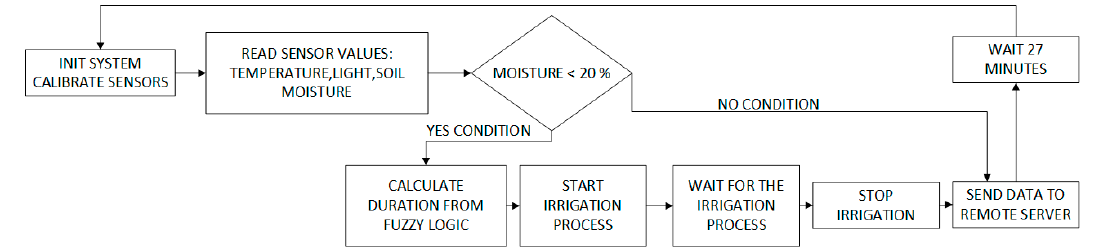
Figure 6. Process workflow: the main loop introduces a time delay in the whole process. Once the sensors are calibrated and measures obtained, the moisture level is checked. If the humidity crosses a given threshold, data is sent to the server. Otherwise, the input values of the sensors are sent to the fuzzy logic algorithm and the irrigation process is triggered.